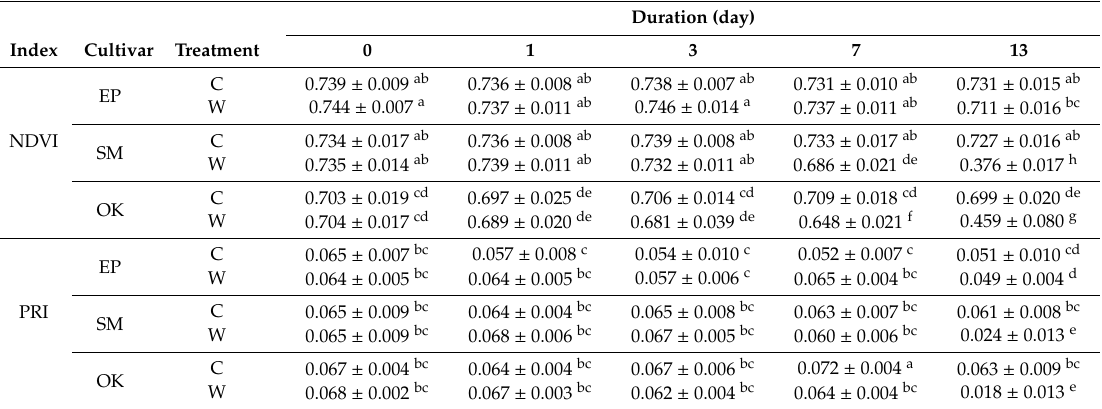
Table 4. E ff ects of waterlogging on normalized di ff erence vegetation index (NDVI) and photochemical reflectance index (PRI) values in EP, SM, and OK squash plants. Plants were grown under optimal Different letters indicate significant difference among various waterlogging treatments of all irrigated (control, C) or waterlogging (W) conditions for di ff erent time periods. cultivars in each index ( p < 0.05). Each value is the mean of ten plants of each cultivar for C or W Duration (day) treatment. Data were collected at 0, 1, 3, 7, and 13 days of waterlogging treatment.